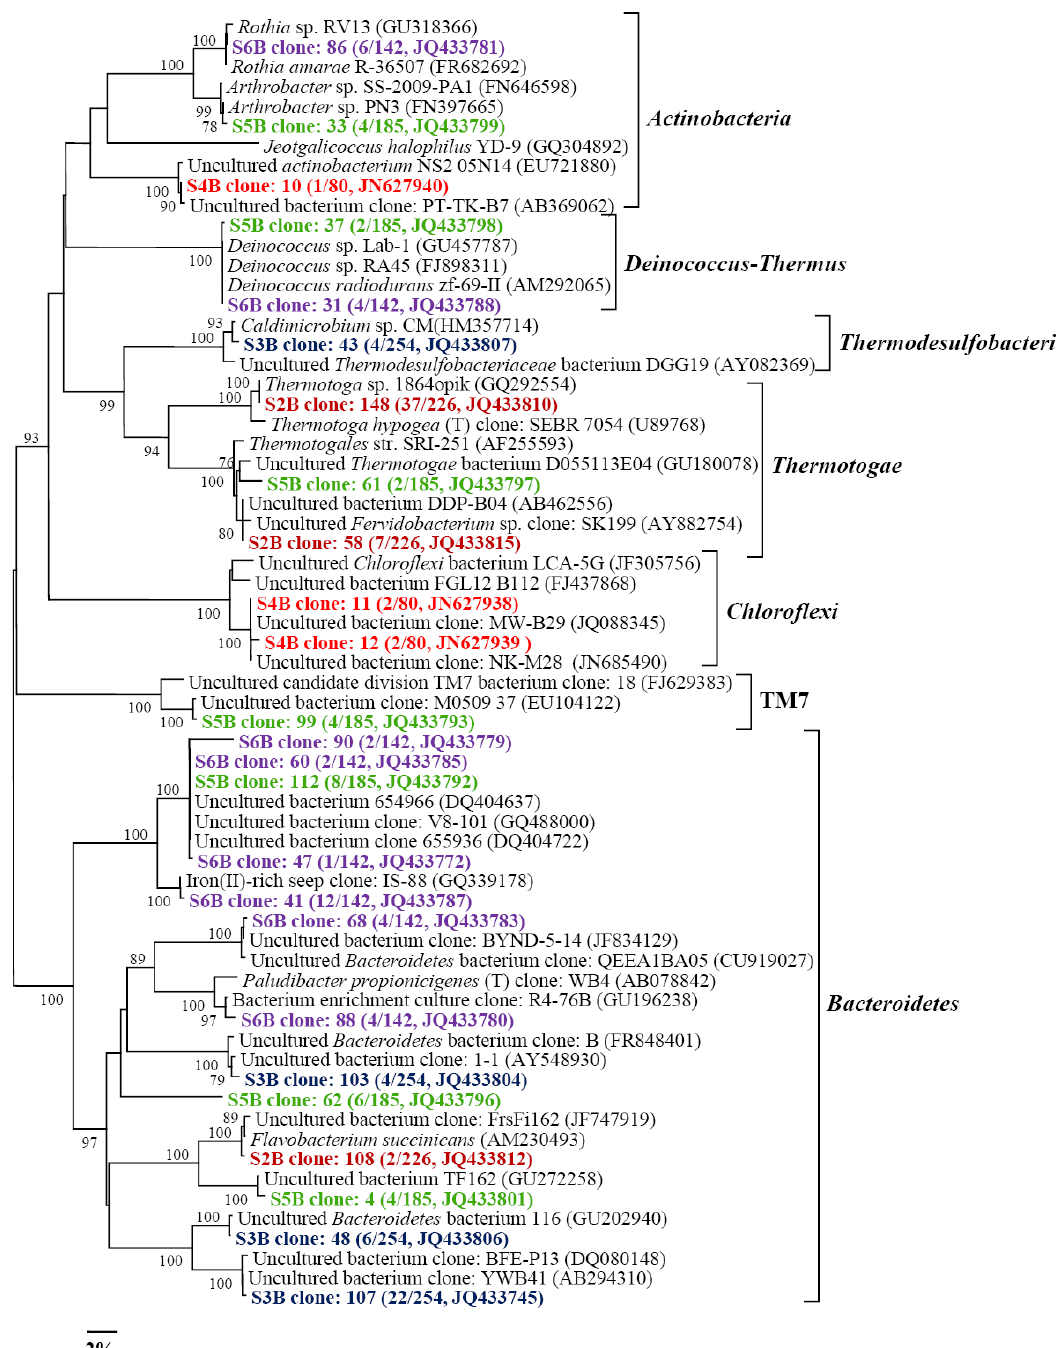
Fig. 3. Phylogenetic tree of the Actinobacteria , Thermodesulfobacteria , Thermotogae , Deinococcus-Thermus , Chloroflexi , Bacteroidetes and TM7 16S rRNA gene phylotypes retrieved from six different petroleum reservoirs (shown in bold) and closely related sequences from GenBank database. Alignments to related sequences (shown with accession number) were performed with MEGA 5 software. The topology of the tree was obtained with the neighbor-joining method. Bootstrap values ( n = 1000 replicates) of ≥ 75% are reported. Scale bar represents nucleotide changes per site. Sampling locations are as named in Table 1.